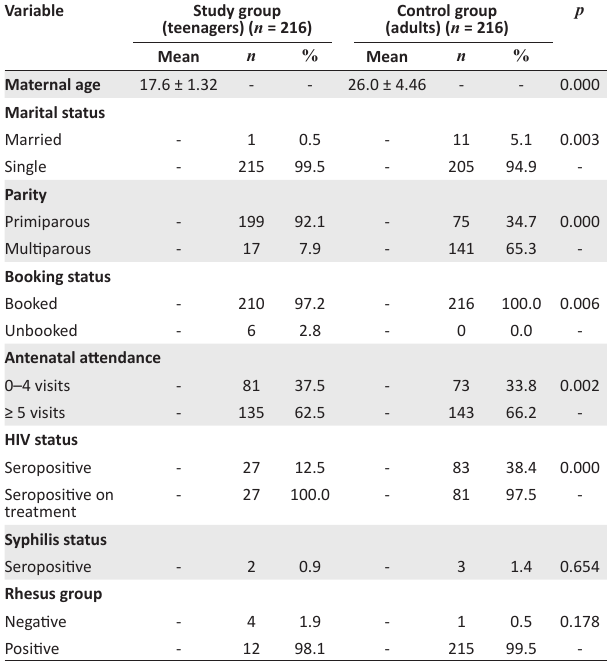
TABLE 1: Demographic